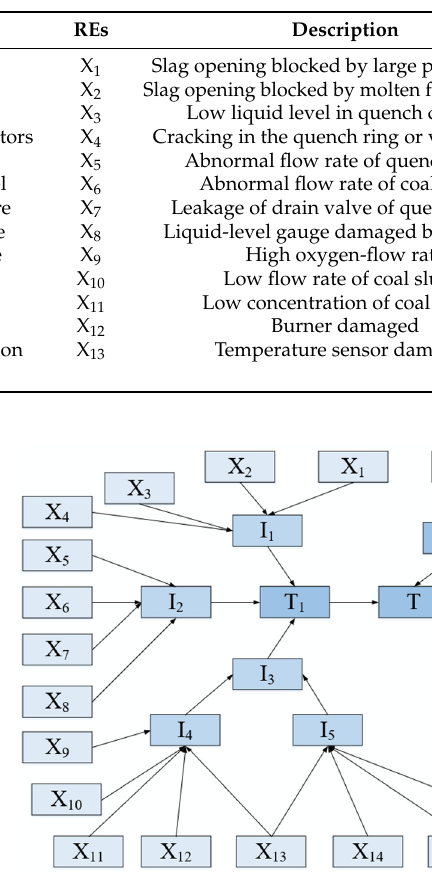
Figure 7. The fault-tree model of the coal gasifier. Table 4. Description of the events in the fault tree of the coal gasifier.